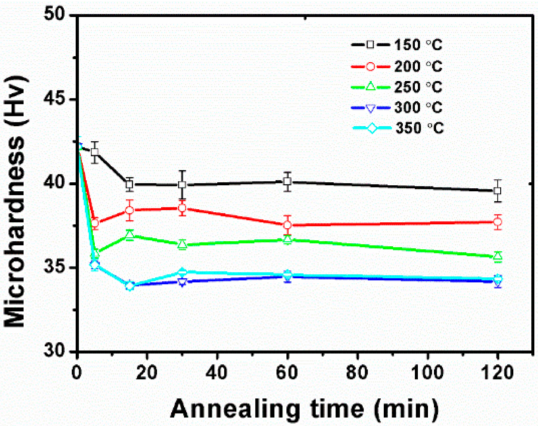
Figure 3. Microhardness of pure Mg with di ff erent annealing treatments.